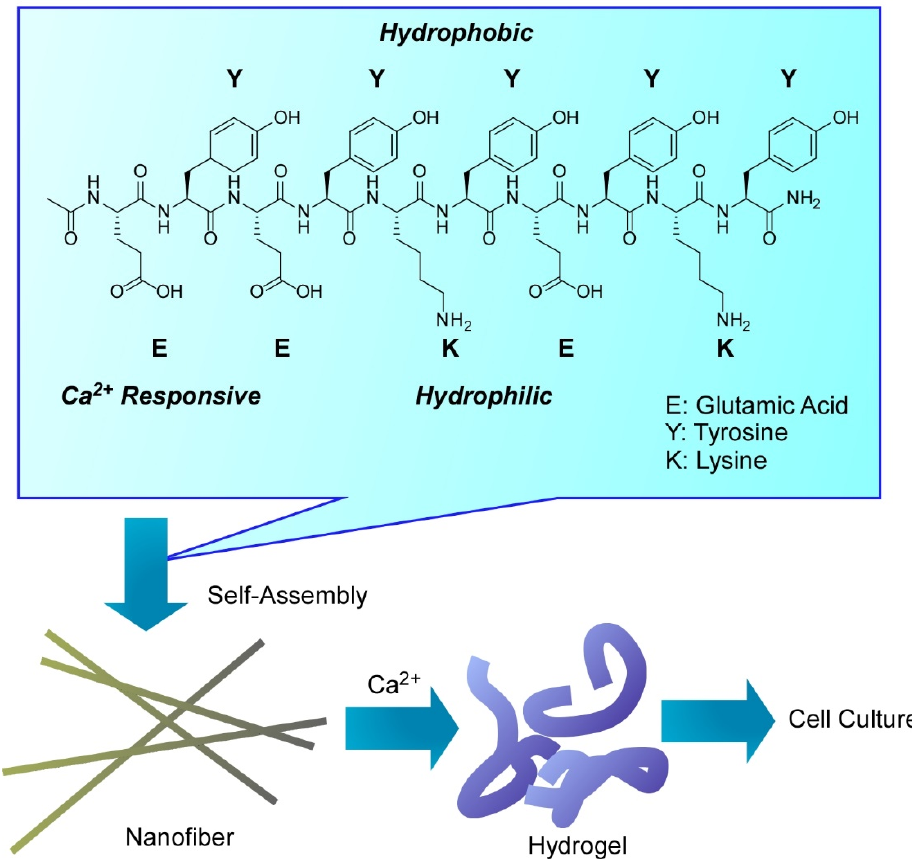
Figure 26. Formation of networked nanofibers and hydrogel with designed peptide (Ac-EYEY- KYEYKY-NH 2 : E, glutamic acid; Y, tyrosine; K, lysine) with the aid of Ca 2+ .